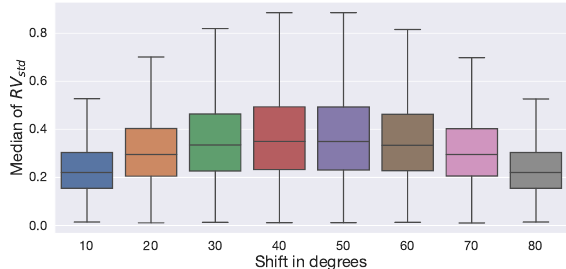
Figure 5. Impact of a shift of camera direction on the standard deviation of the scores when using only a 4-split, for the safety attribute.